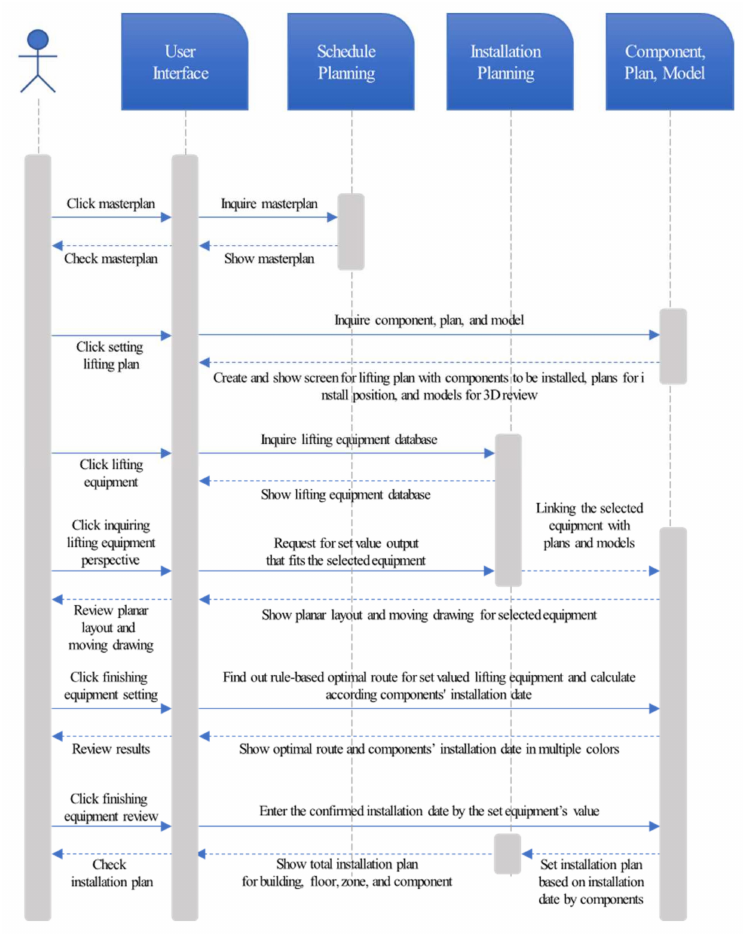
Figure 4. Use-case diagram for site installation planning